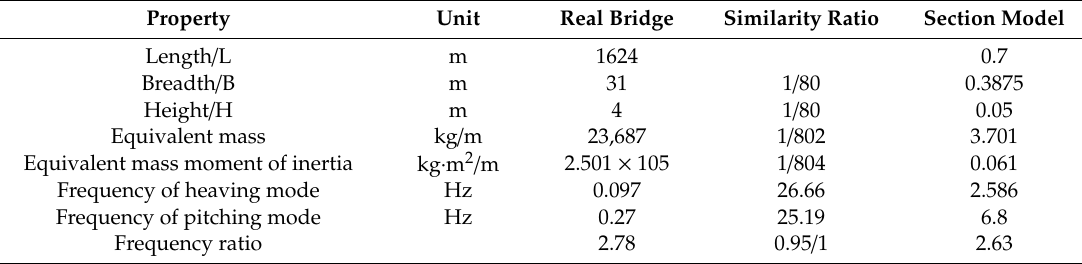
Table 2. Parameters of bridge section